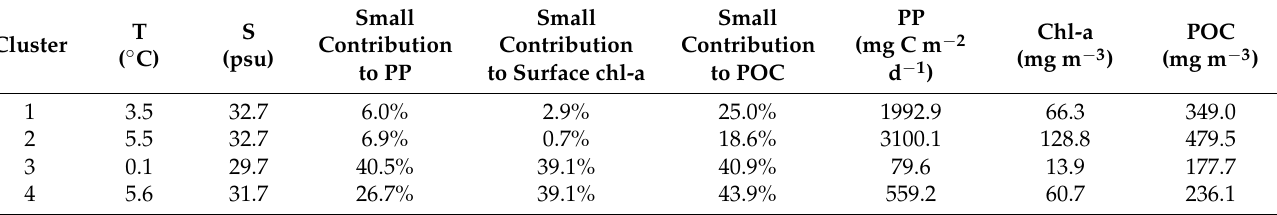
Table 3. Mean values of properties for the 4 clusters classified by the